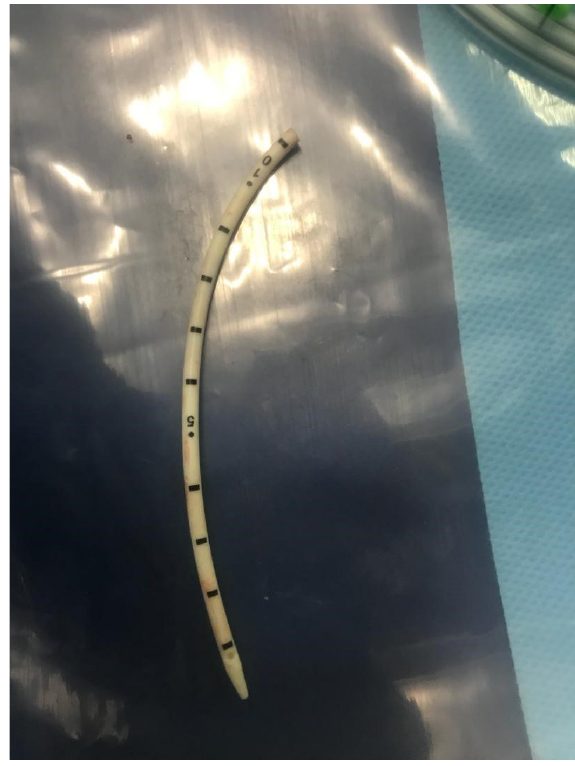
Figure 2. The Removed Catheter After Percutaneous